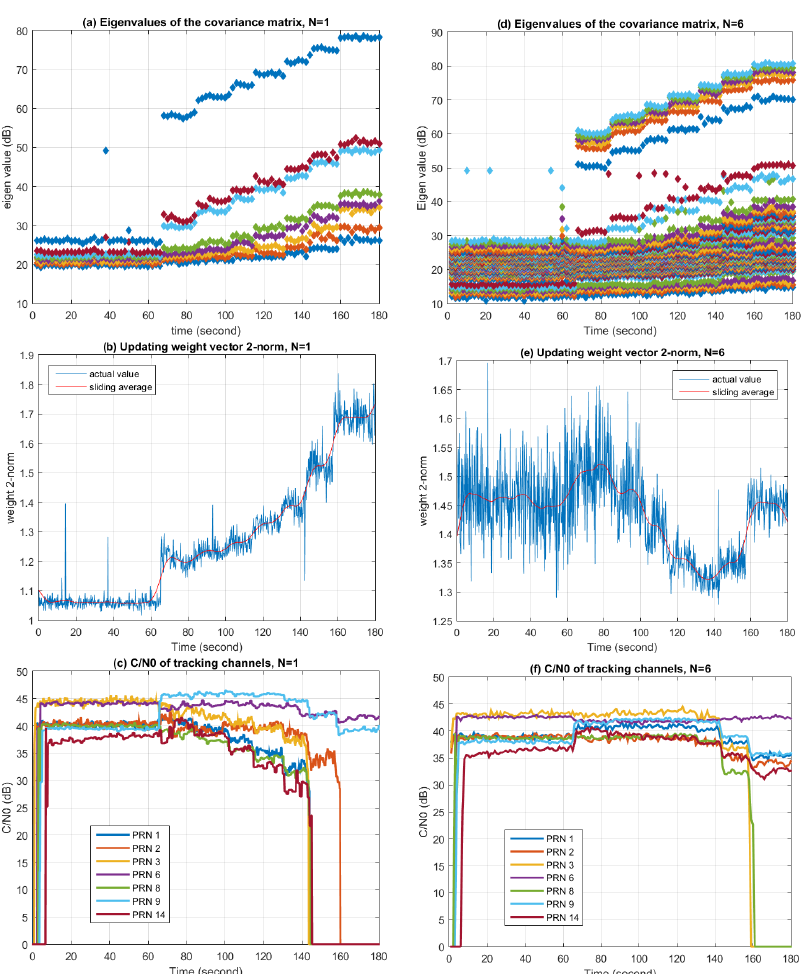
Figure 19. Performance of the STAP nulling during Jamming Scenario 1. ( a ) Eigenvalues of the corvariance matrix when N is 1; ( b ) 2-norm of the updating weight vector when N is 1; ( c ) C/N0 of the tracking channels when N is 1; ( d ) Eigenvalues of the corvariance matrix when N is 6; ( e ) 2-norm of the updating weight vector when N is 6; ( f ) C/N0 of the tracking channels when N is